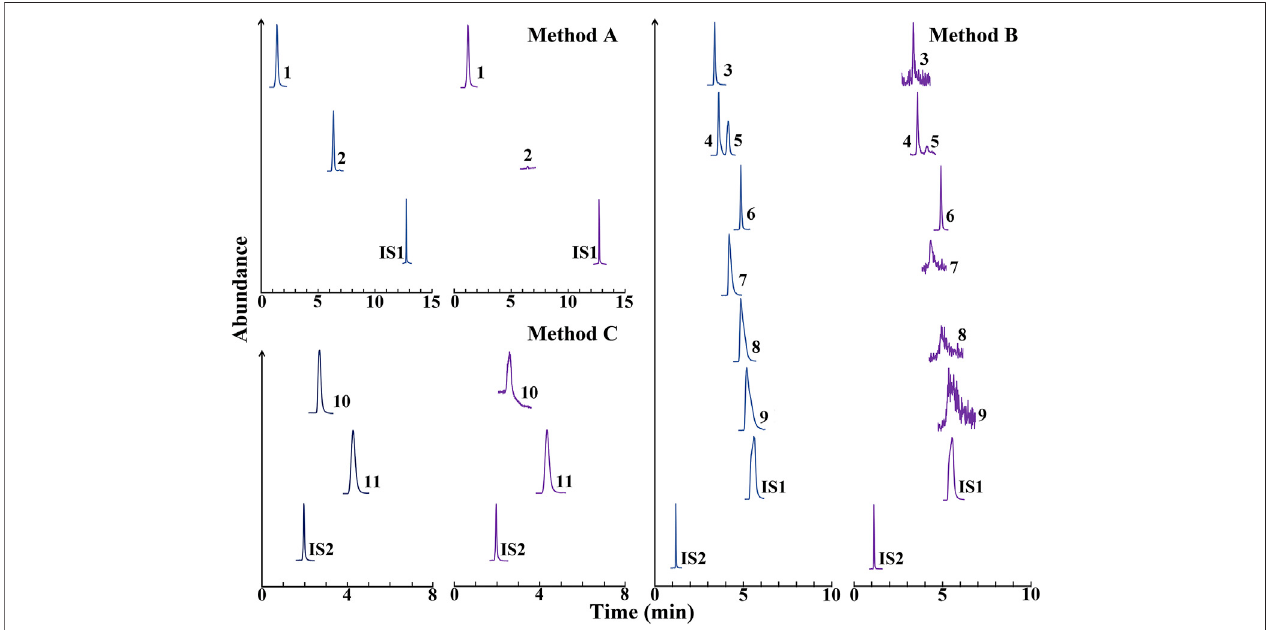
FIGURE 1 | Representative multiple reaction monitoring chromatograms of the analytes in methods (A,B,C) . Blue peaks, reference compounds, and internal standards(IS);Purplepeaks, CoptidisRhizoma extractspikedwiththereferenceinternalstandards.IS1,mycophenolicacid;IS2,tetraethylamine.1,malicacid;2,caffeic acid; 3, xylitol; 4, glucose; 5, fructose; 6, sucrose; 7, proline; 8, alanine; 9, glycine; 10, urea; 11, choline chloride.